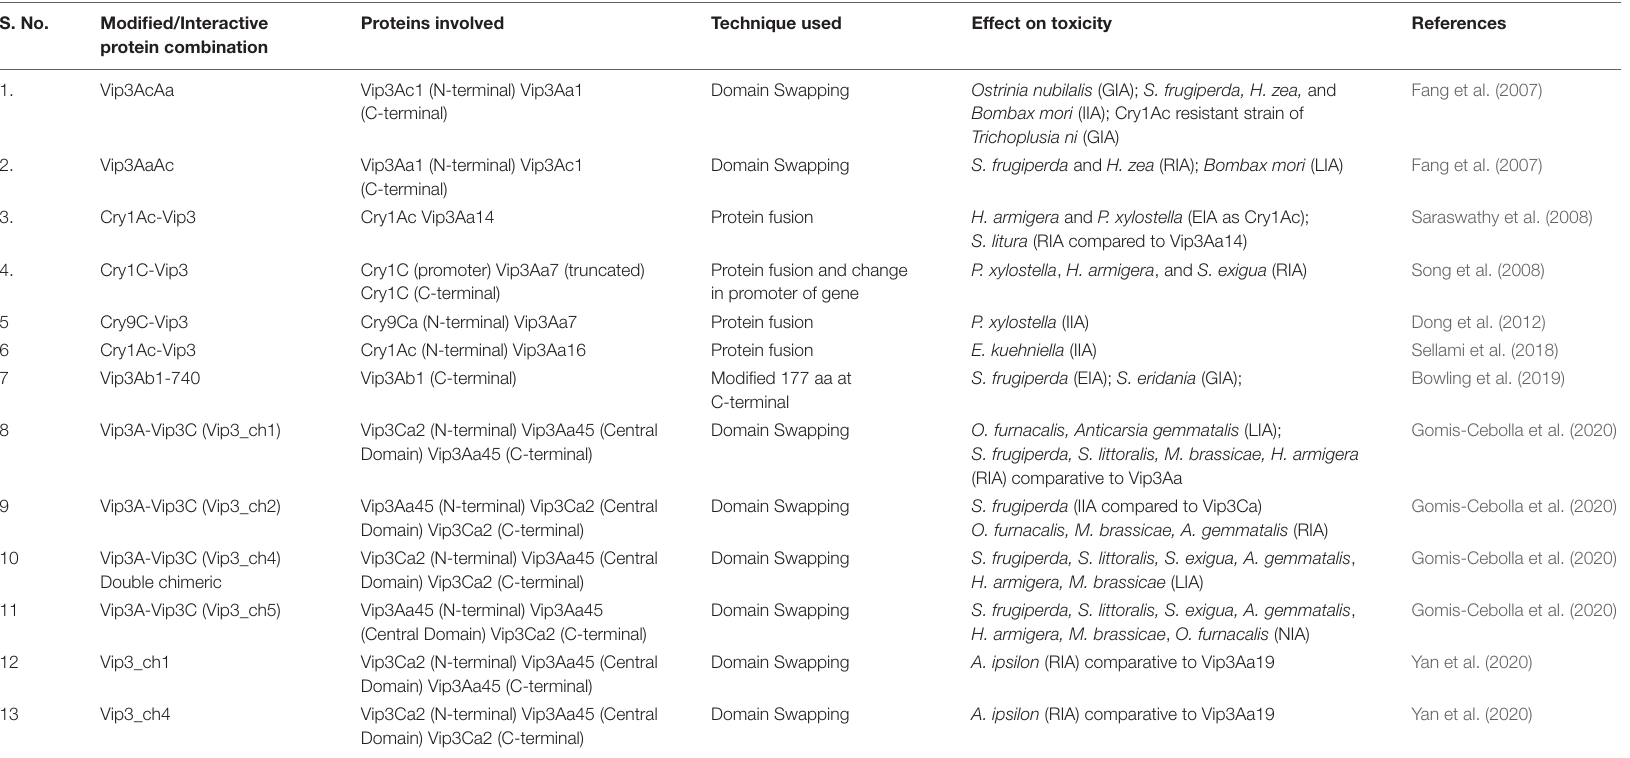
TABLE 3 | Chimeric Vip3A proteins alone or in combination with Cry proteins and effects on insecticidal activity against target pests. S.